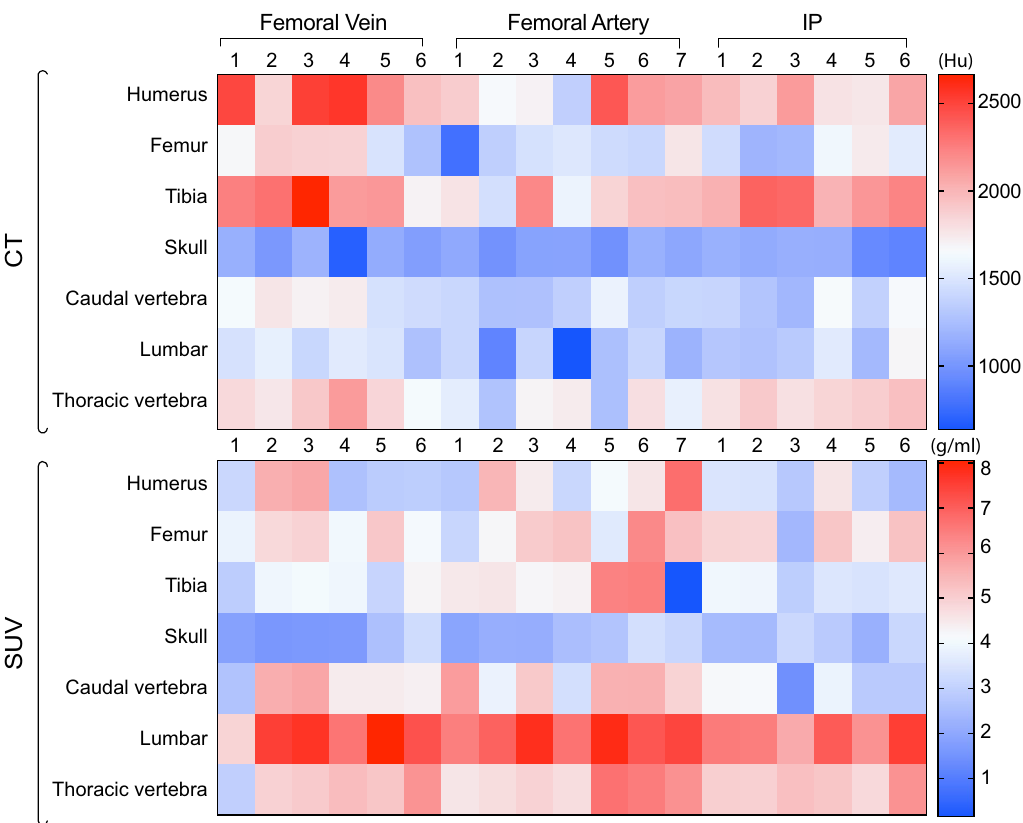
Figure 3. Heatmap comparing CT values versus PET uptake of 18 F-NaF for each bone after femoral artery, femoral vein or intraperitoneal (IP) injection. Each column represents a mouse replicate per administration route. CT values are expressed as hounsfield units (HU) and standardised uptake values (SUVs) as